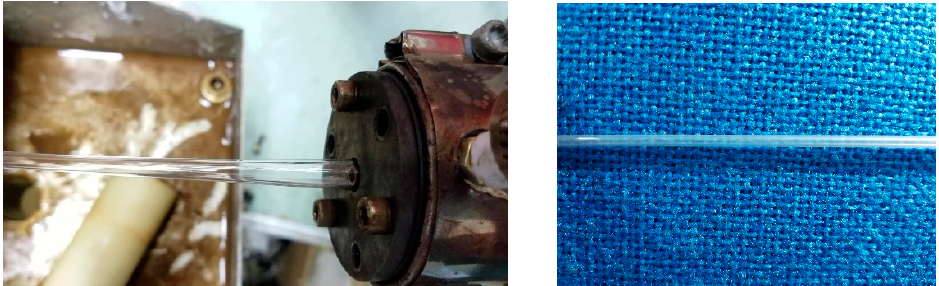
Figure 17. Micro-tube formation under 1000 Pa.